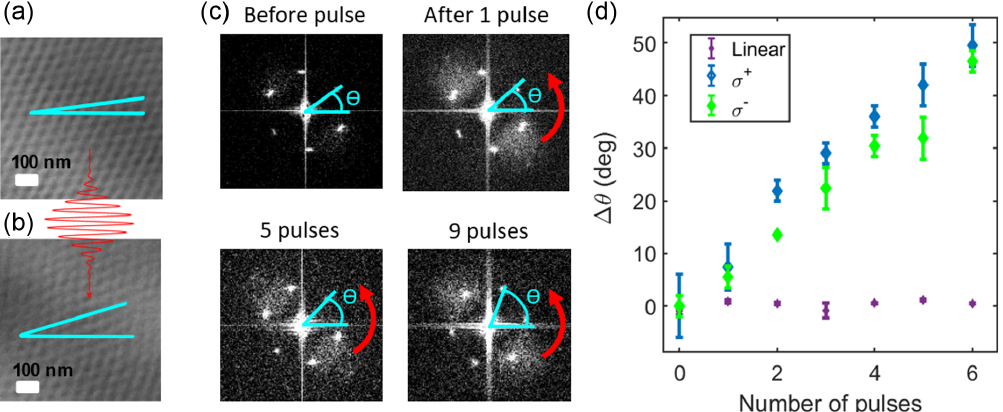
FIG. 1. Illustration and schematic of laser-driven skyrmion crystal rotation process. (a) Real-space images of skyrmion crystal in Cu 2 OSeO 3 taken before excitation with the laser pulse and (b) after six successive near-infrared laser pulses each rotate the skyrmion crystal by a discrete amount. Note that the angle (depicted in blue) to the horizontal changes. (c) Fourier transforms of LTEM images following successive pulses of 8 mJ = cm 2 of near-infrared femtosecond laser excitation. The angle of the hexagonal ordering of the skyrmion crystal changes as a function of the number of pulses applied to the sample. (d) Tracking the position of a single peak in the FT of an image while pumping the sample with individual femtosecond laser pulses. Note that σ þ and σ − polarizations both rotate the skyrmion crystal in the same direction, while linear polarization does not rotate the skyrmion crystal. The error bars are 95% confidence intervals calculated from the data and multiplied by an uncertainty factor determined from the noise level in the